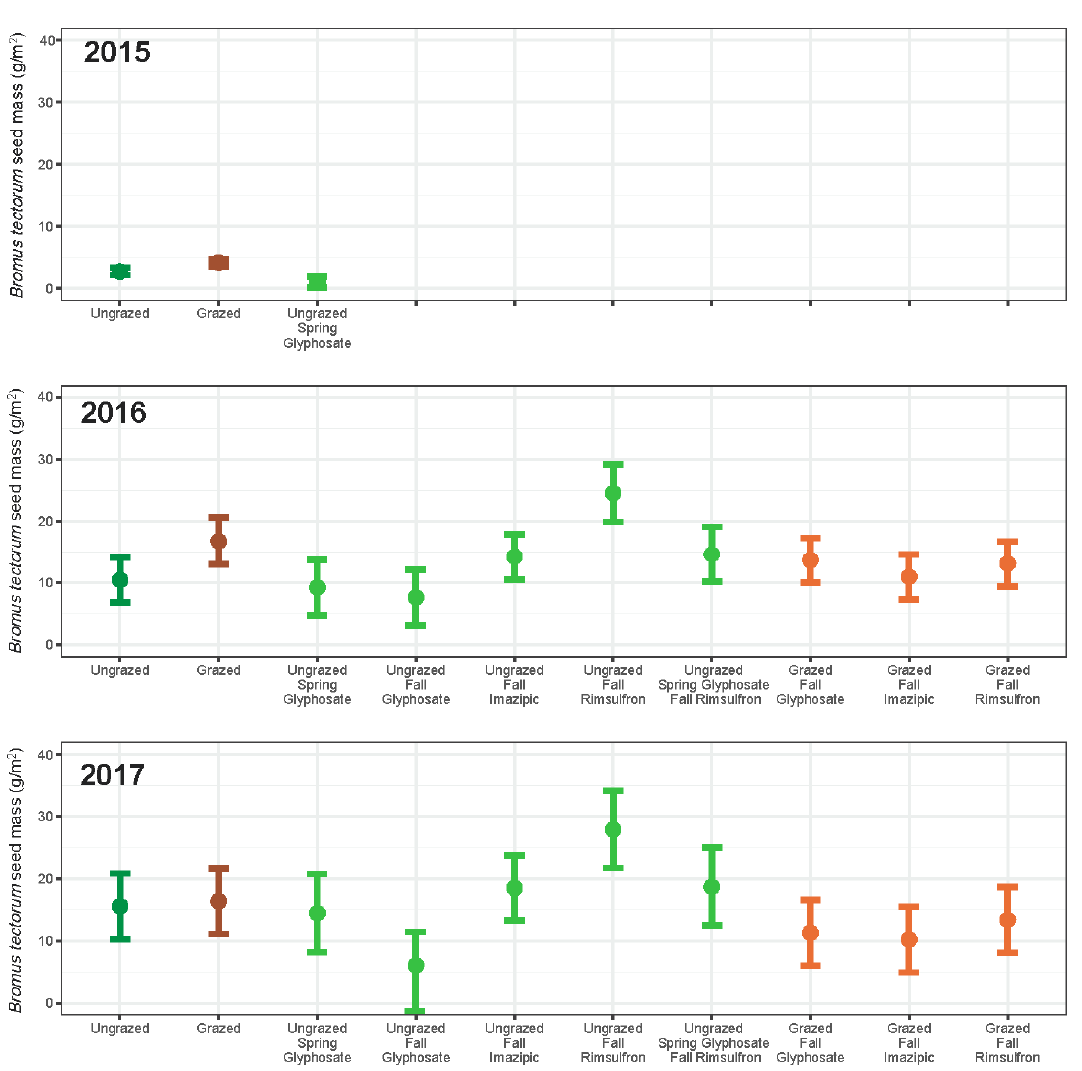
Figure 3. Fitted model results for Bromus tectorum seed weight (g; mean ± SE) response to grazing, herbicide and integrated treatments at Red Bluff, Montana in 2015, 2016, and 2017. Fall herbicide treatments were implemented after the summer data collection in 2015, so these treatments do not show results in 2015. Furthermore, fall herbicide results in 2016 and 2017 represent treatments implemented in the prior years. Data shown are predicted values from linear mixed effects models, and thus the means are not identical to means from the raw data.